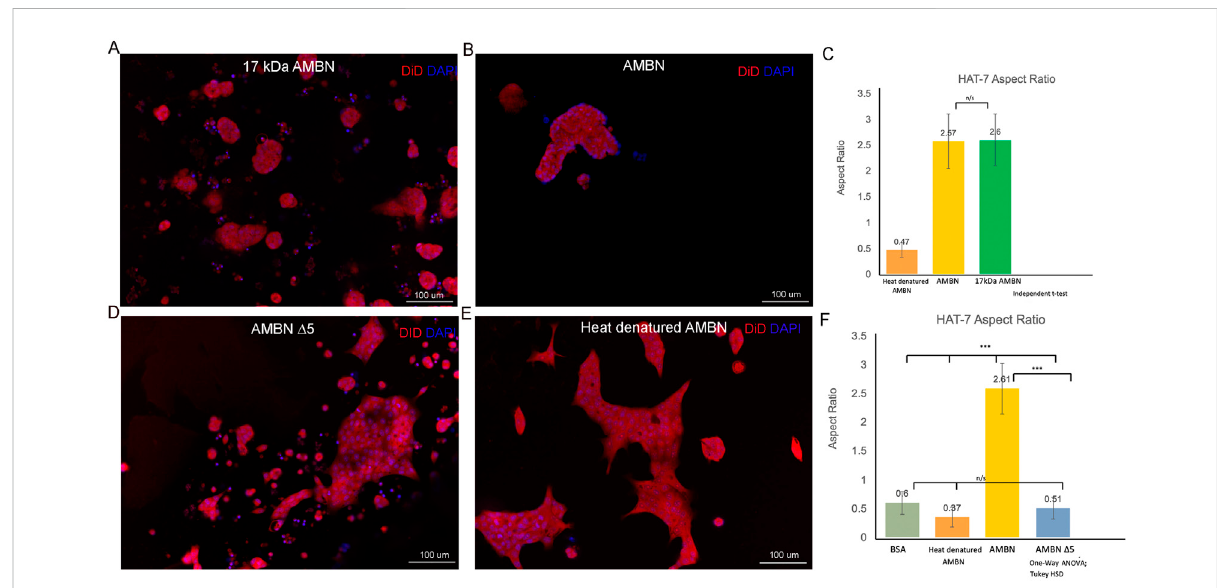
FIGURE 3 HAT-7 cells cultured with AMBN 17 kDa fragment and AMBN Δ 5 mutant. (A , B) . XY surface images of HAT-7 cells cultured in the presence of AMBN 17 kDa fragment and wild-type full-length AMBN respectively. HAT-7cells organizedinto distinctclustersofcells inboth groupsas visualized using DiD (red) and DAPI (blue). (C) . Aspect ratio measurements of HAT-7 cells cultured with 17 kDa fragment, positive and negative controls revealing statistically comparable HAT-7 cell elongation in AMBN 17 kDa cleavage fragment and positive control (full-length AMBN); p > 0.05. (D , E) . XY surface images of HAT-7 cells cultured with mutant AMBN Δ 5, and heat denatured AMBN respectively. (F) . Aspect ratio measurements of HAT-7 cells in the presence of AMBN Δ 5. Removal of exon 5 encoded sequence resulted in HAT-7 cells remaining planar with aspect ratio